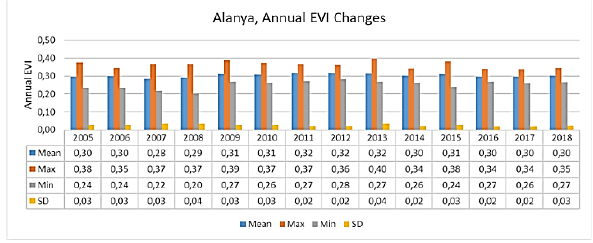
Figure 4. Annual EVI change from 2005-2018